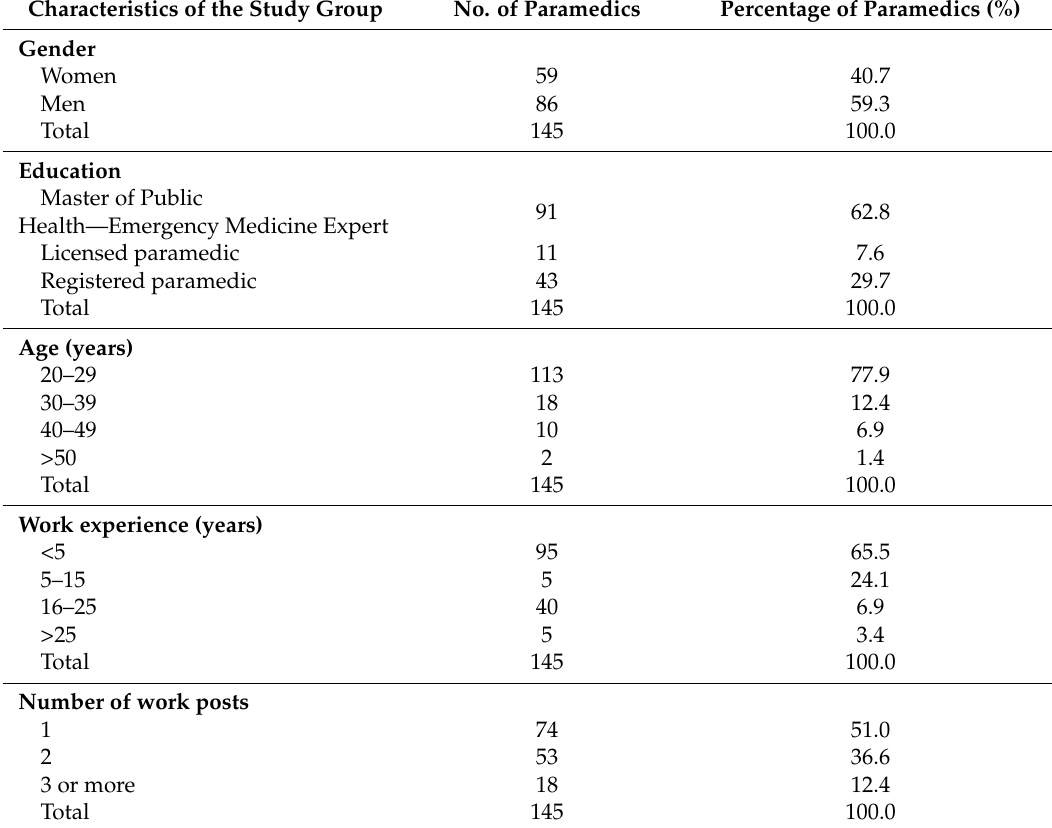
Table 1. Characteristics of the study